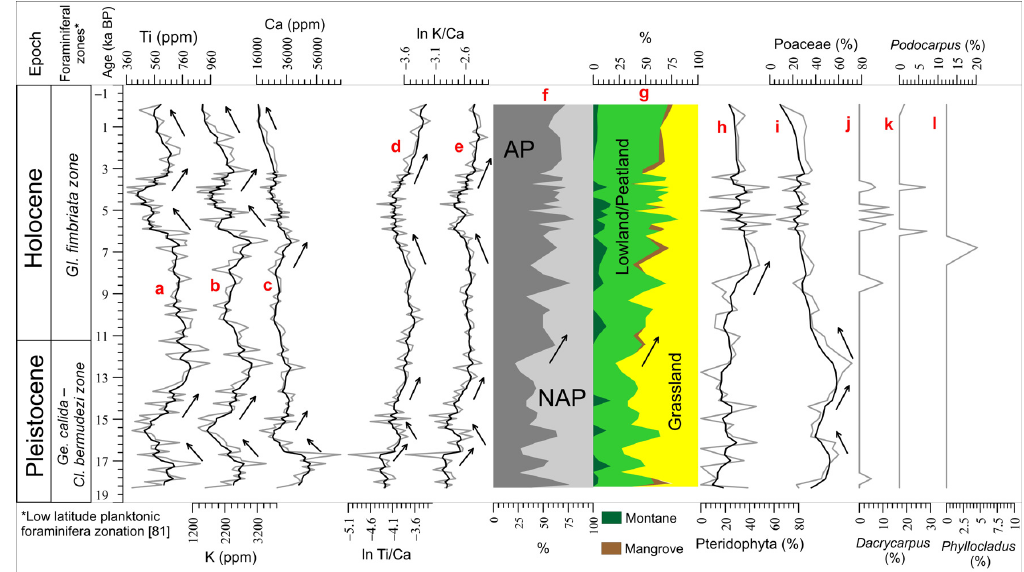
Figure 6. Geochemical elements obtained from XRF ( a – c ) and proxies used to infer AIM rainfall (( d , e ): terrigenous input proxies, ( f – i ): pollen and spore proxies) (Tables S3 and S4). Pollen taxa indicating the source area of pollen and spores are also presented ( j – l ). Data are plotted against the mean ages obtained from the age model. Black curves indicate smoothed values (exponential smoothing).